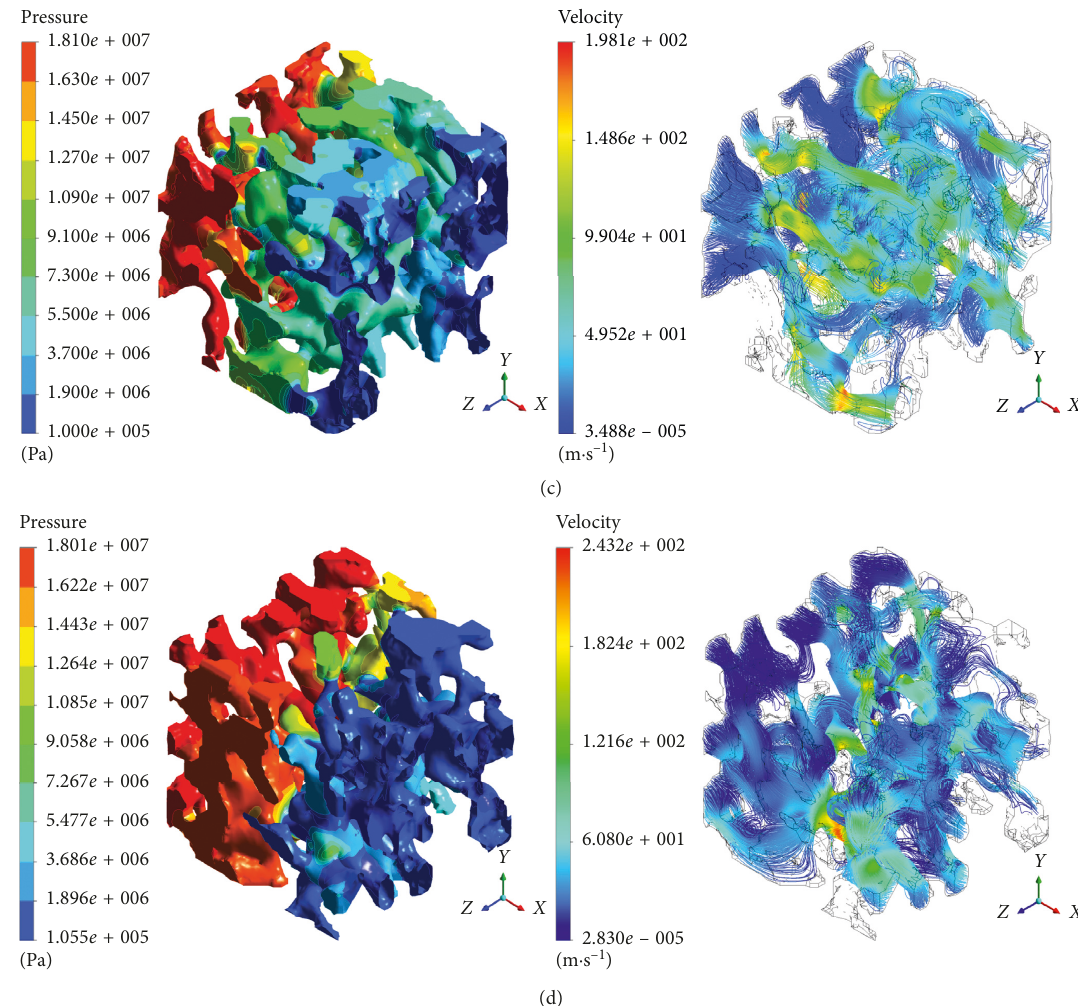
Figure 22: Distribution of pressure and velocity fields in four different models under an ultrahigh inlet pressure of 18.1MPa. (a) Results in model P 1 . (b) Results in model P 2 . (c) Results in model P 3 . (d) Results in model P 4 . Table 6: Simulated results of seepage parameters in four models under a low inlet pressure of 4.3MPa. Model